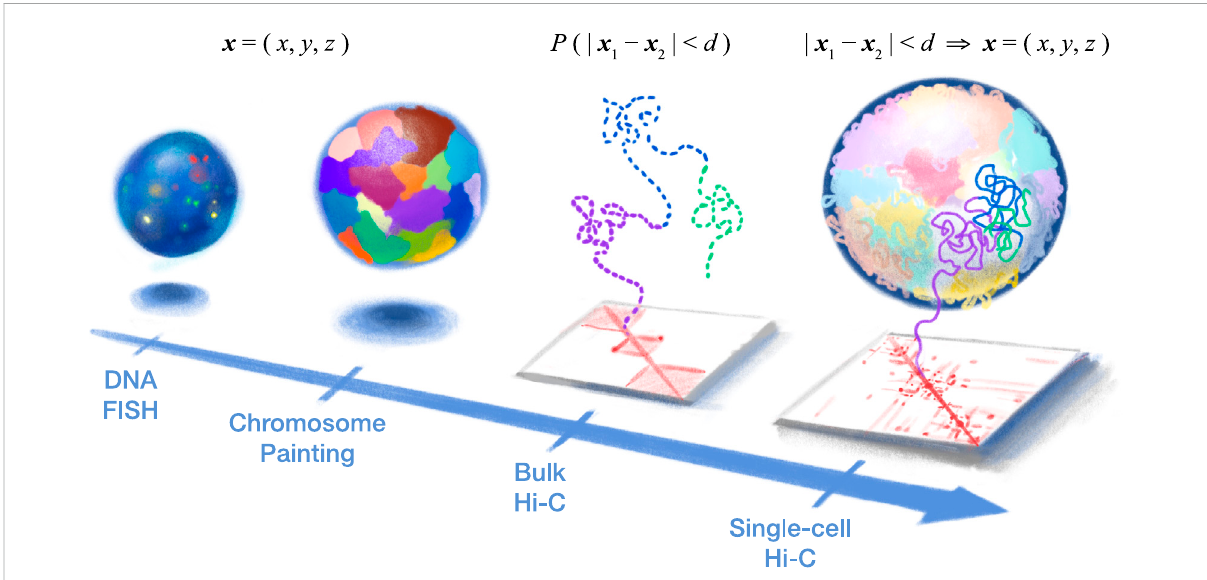
FIGURE 1 Single-cell Hi-C provides a holistic high-resolution view into the 3D structure of our genetic blueprint. (Left) DNA fl uorescence in situ hybridization (FISH) provided the fi rst look into genome organization in the cell nucleus by directly measuring 3D coordinates (i.e., x , y , and z ) of various genomic loci (or entire chromosomes, in the case of chromosome painting) but is limited by the optical resolution and spectrum (i.e., the number of loci). (Right) Chromosome conformation capture (3C or Hi-C) indirectly measures nuclear architecture through 3D proximity betweengenomicloci(i.e., “ contactmap ” ).BulkHi-Cmeasurestheaverage3Dproximity(probability( P )thattwolociarewithinacertain3Ddistance ( d )) among a large population of cells and, therefore, cannot produce true 3D structures (dashed line). In particular, the “ all-to-all ” inter- chromosomal contacts in bulk Hi-C provide con fl icting spatial constraints, while chromatin domains (three are depicted here) would be seemingly isolated from each other. In contrast, single-cell Hi-C offers a new concept of a “ biochemical microscope. ” 3D proximity of a single cell can be converted into actual 3D coordinates of the whole genome, yielding high-resolution structures without the need for specialized